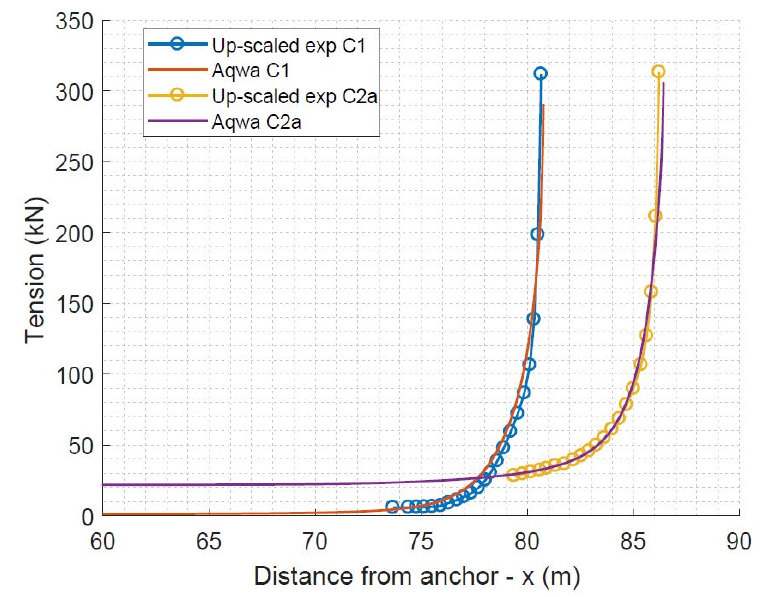
Figure 11. Static characteristics of the two mooring